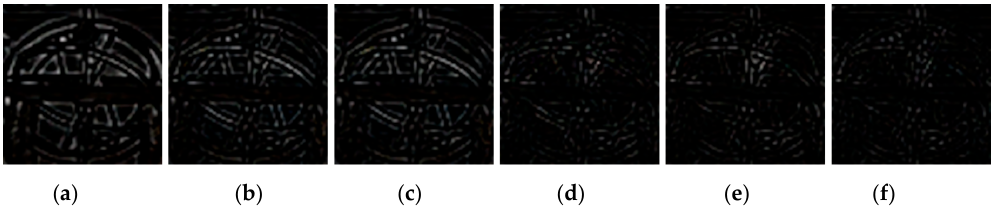
Figure 13. Difference images between the region marked with the green box in Figure 12a and its deblurred results. ( a ) ECP; ( b ) EPLL; ( c ) NCSR; ( d ) SRN; ( e ) DPDNN; ( f ) proposed method.